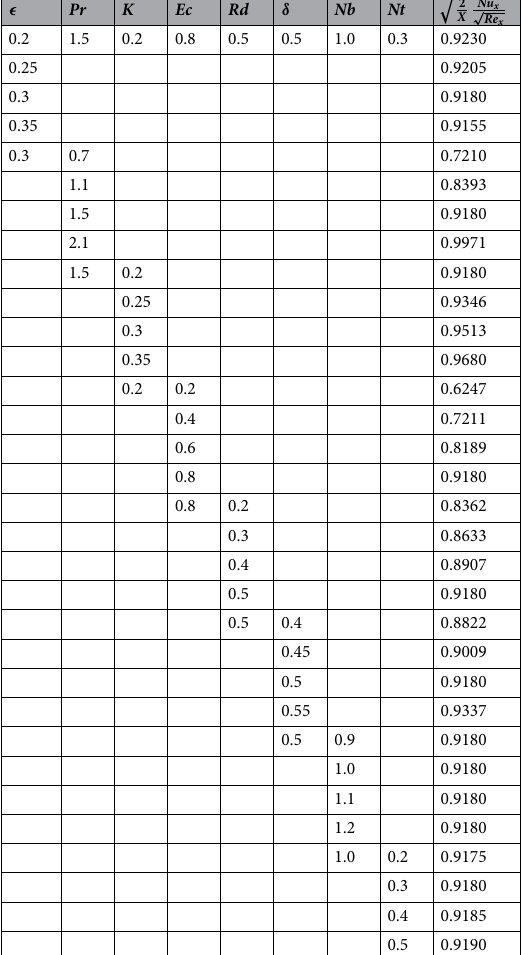
Table 2. Variation of Nusselt number with ǫ , Pr , K , Ec , Rd , δ , Nb , and Nt